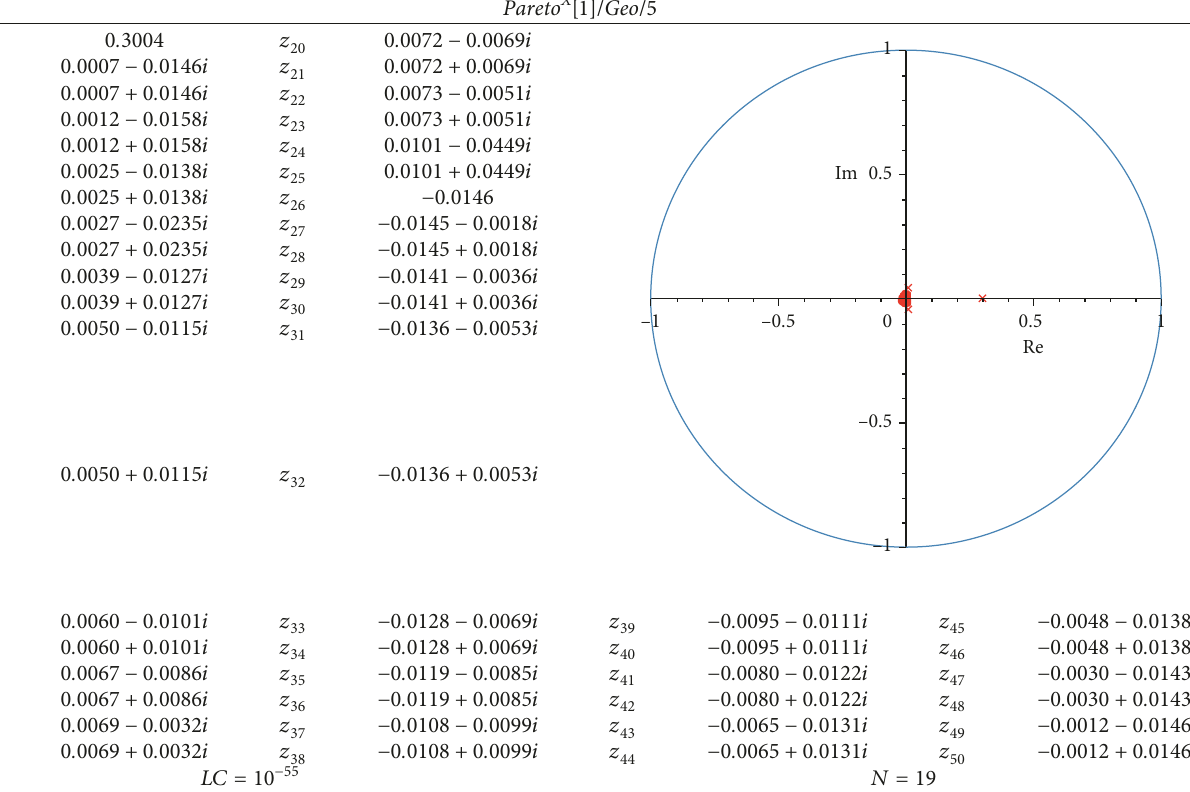
� ( 1/ ( 􏽐 r ( P l / l ! )))( P h / h ! ) ( P � 0 . 3 , r � 50 ) and ρ � h l � 1